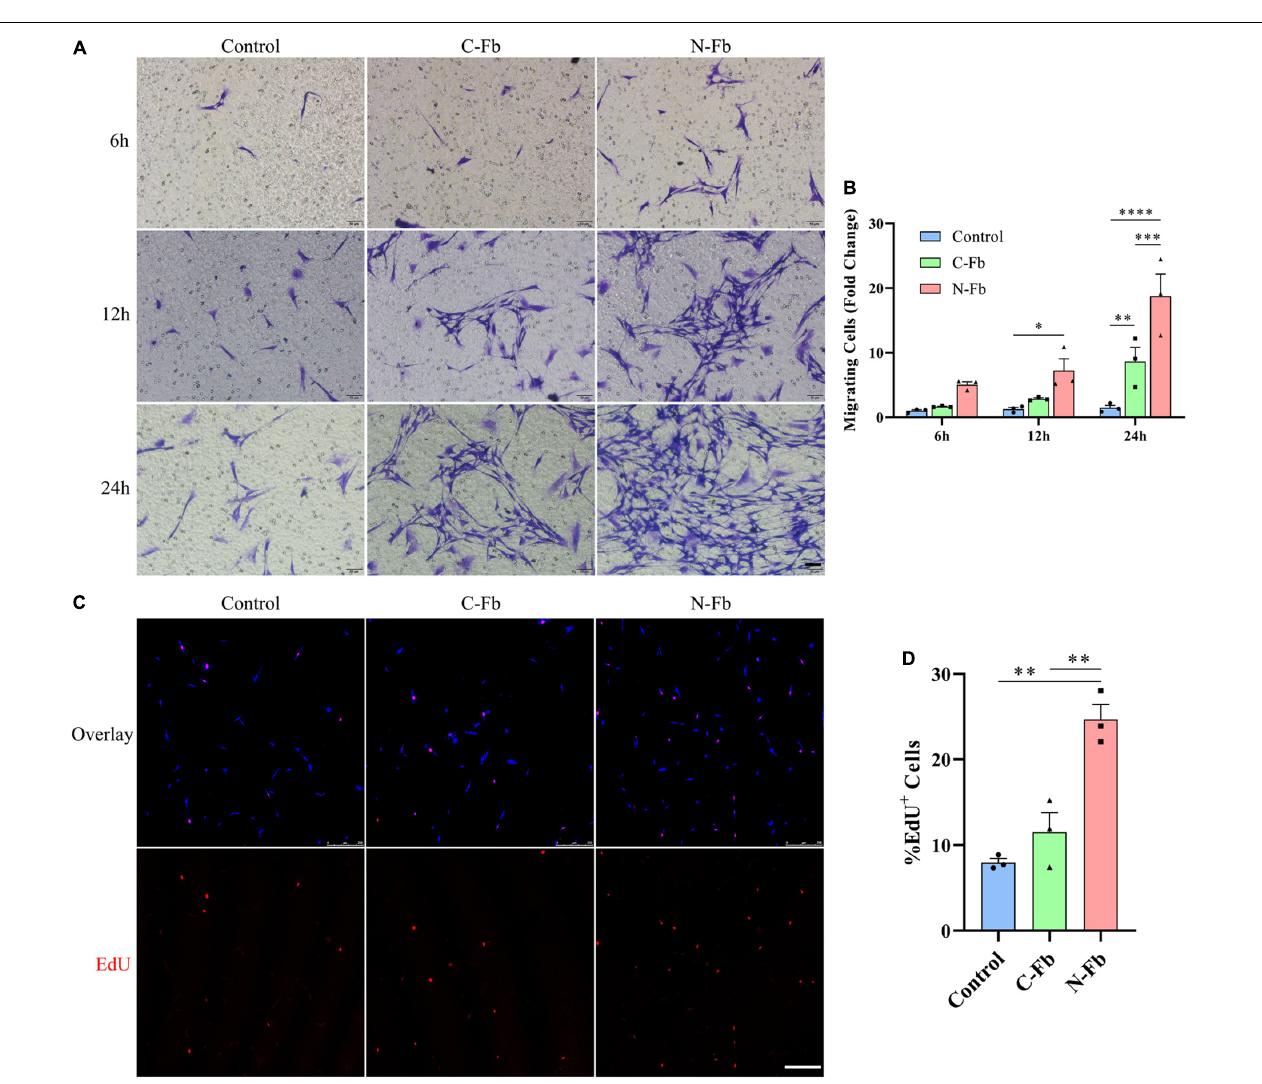
FIGURE 2 | N-Fbs facilitates Schwann cells migration and proliferation in vitro . (A) Phase-contrast micrographs of crystal violet-labeled migrated SCs co-cultured with blank control, C-Fbs, and N-Fbs in transwell for 6 h, 12 h, and 24 h. Scale bar, 50 µ m. (B) Migrating SCs quantification (three independent experiments). Statistical significance is indicated as ∗ p < 0.05 N-Fb-12h vs. Control-12h, ∗∗ p < 0.01 C-Fb-24h vs. Control-24h, ∗∗∗ p < 0.001 N-Fb-24h vs. C-Fb-24h, ∗∗∗∗ p < 0.0001 N-Fb-24h vs. Control-24h (two-way analysis of variance followed by Tukey’s post hoc test). (C) EdU + SCs (red) were labeled after 24-h co-culture with N-Fbs and C-Fbs, separately. Scale bar, 75 µ m. (D) Quantification of the proportion of EdU + SCs (three independent experiments). Statistical significance is indicated as ∗∗ p < 0.01 (one-way analysis of variance followed by Tukey’s post hoc test).